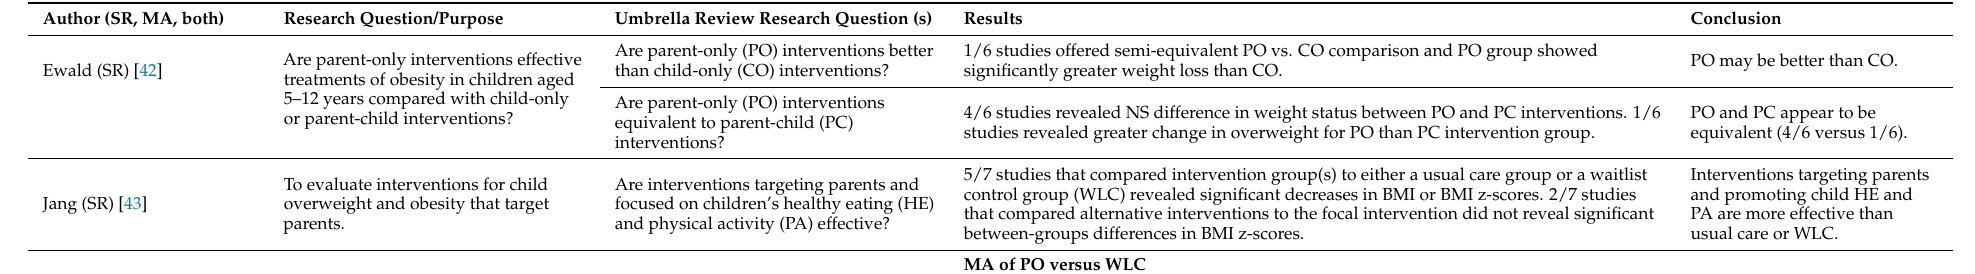
Table 3. Research Questions and Results for SRs/MAs of Treatment